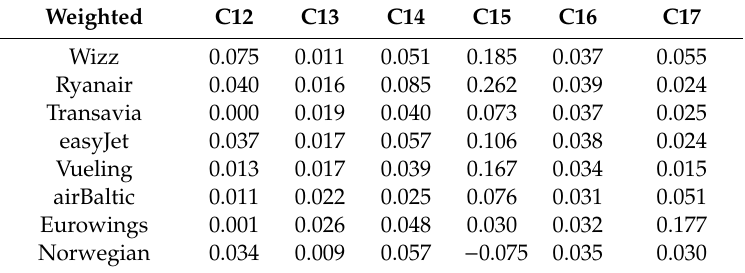
Table A8. Full calculations of the successfulness TOPSIS.